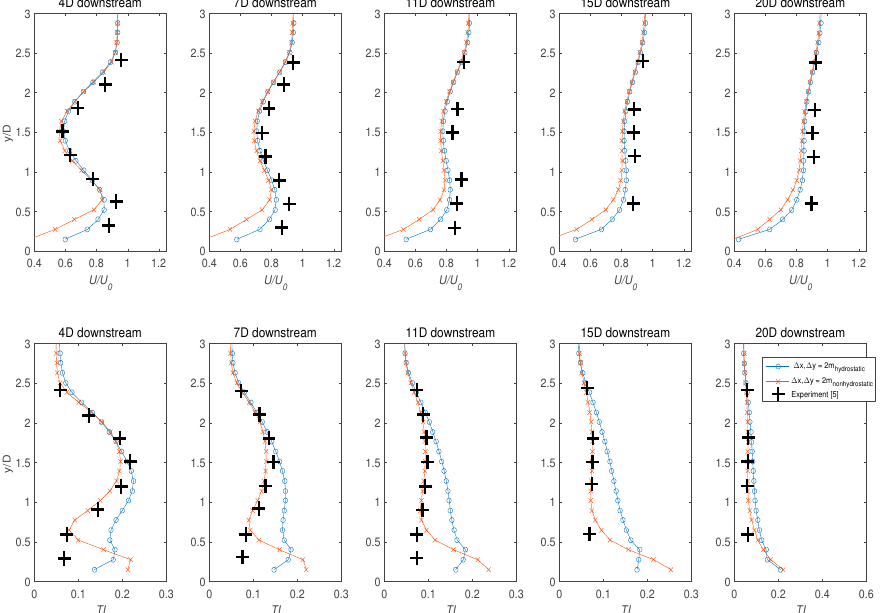
Figure 10. Comparison between hydrodynamic and non-hydrodynamic assumptions on the models. The vertical resolution ∆ z and the size of the structured grid ( ∆ x & ∆ y ) were maintained at 24 sigma layers and 2 m, respectively for all cases.